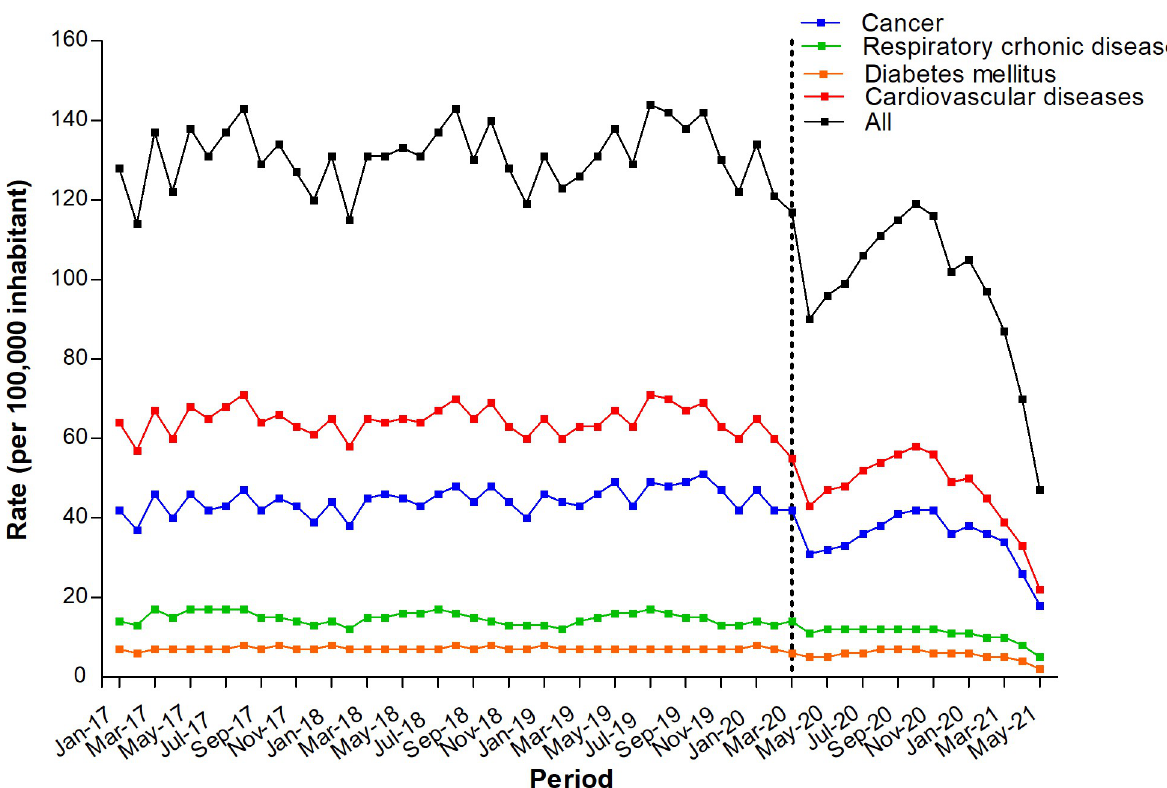
Fig 1. Hospital admission rate for chronic non-communicable diseases (NCDs) in Brazil according to the type of NCD. Pre-pandemic period: January 1, 2017 to February 29, 2020; Pandemic period: March 1, 2020 to May 31, 2021.